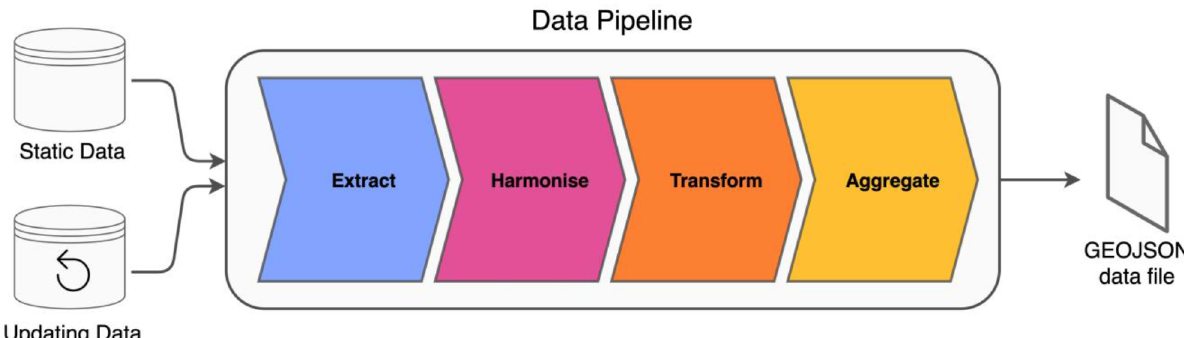
Figure 2: A schematic of the data processing pipeline